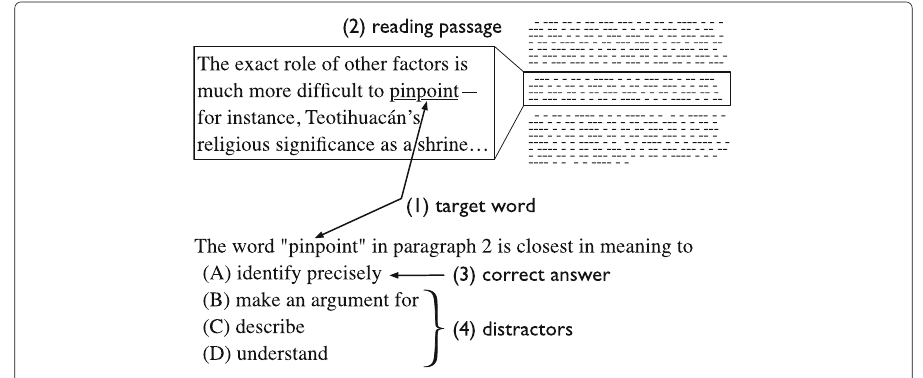
Fig. 1 Four components in a multiple-choice question asking for closest-in-meaning of a word (source: TOEFL iBT question from past test, taken from the official website, www.ets.org)